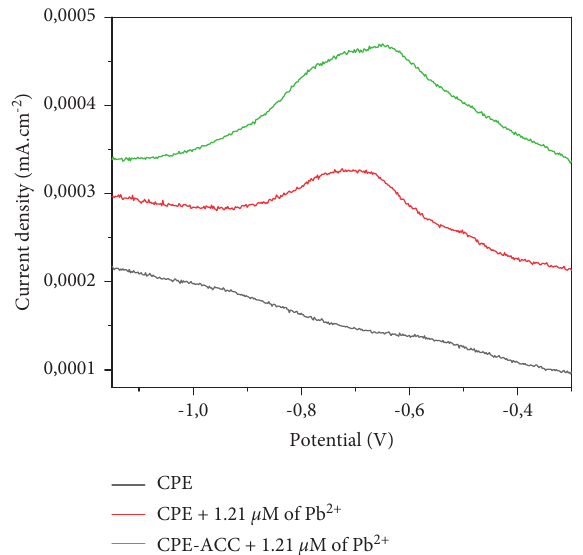
Figure 3: Sensibility of electrodes with Pb 2+ by SWV.